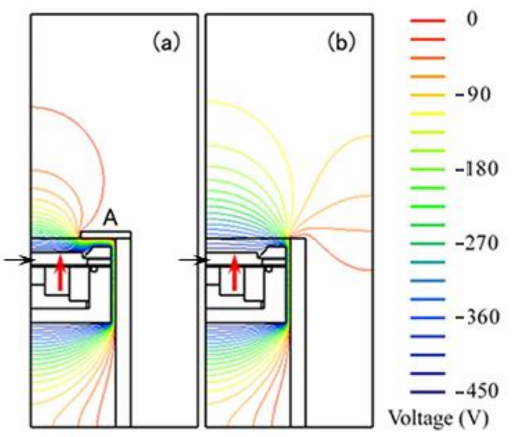
Figure 1. Right-side cross sections of a planar magnetron and electric potential distributions calcu- lated by an axial target model using a finite-element-method electromagnetic field analysis simulator (Mutec, µ -Excel) as the sputtering source. Grounded anode structures ( a ) with a flat, ring-shaped shield (standard type) and ( b ) without a flat, ring-shaped shield. The black and red arrows indicate the target and the erosion position of the target, respectively. The calculated results exclude the indication of the potentials of target and the magnetron for